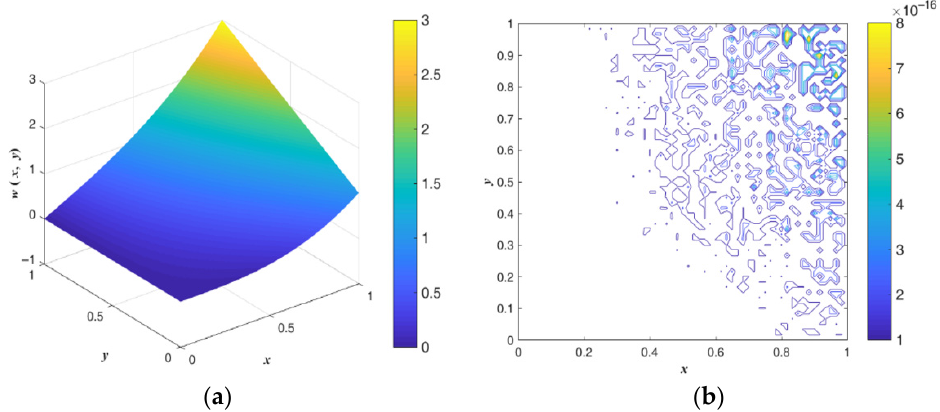
Figure 12. Potential distributions for a nonlinear Poisson problem: ( a ) numerical solution; ( b ) absolute errors.